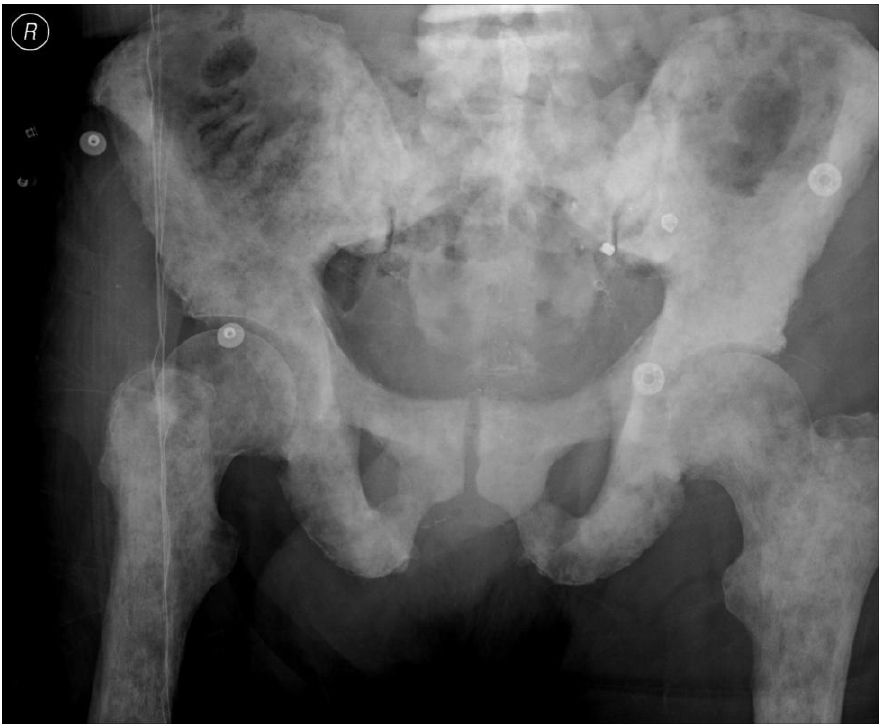
FIGURE 1. Anteroposterior radiograph of the pelvis demonstrating multiple osteosclerotic metastases from prostate adenocarcinoma. The sclerotic metastases are seen throughout all the skeletal